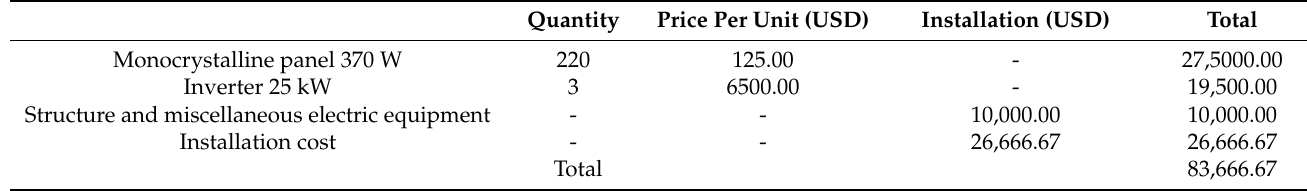
Table 20. Equipment and installation cost of renewable energy system.